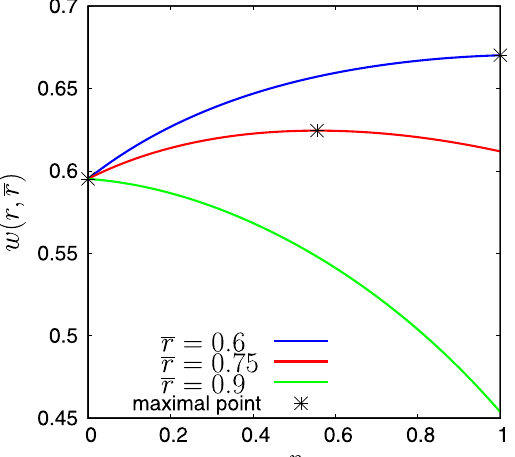
Figure 3. Plots of the function w ( r , r ) versus r for various values of r . Parameters: N = 10, q C = 0.2, q I = 0.3, q O =